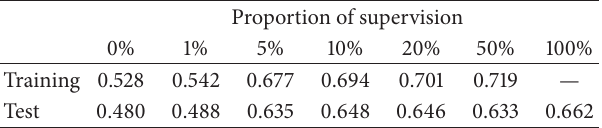
Table 4: Comparison of recognition rates with and without virtual objects ( CiteSeer -training).